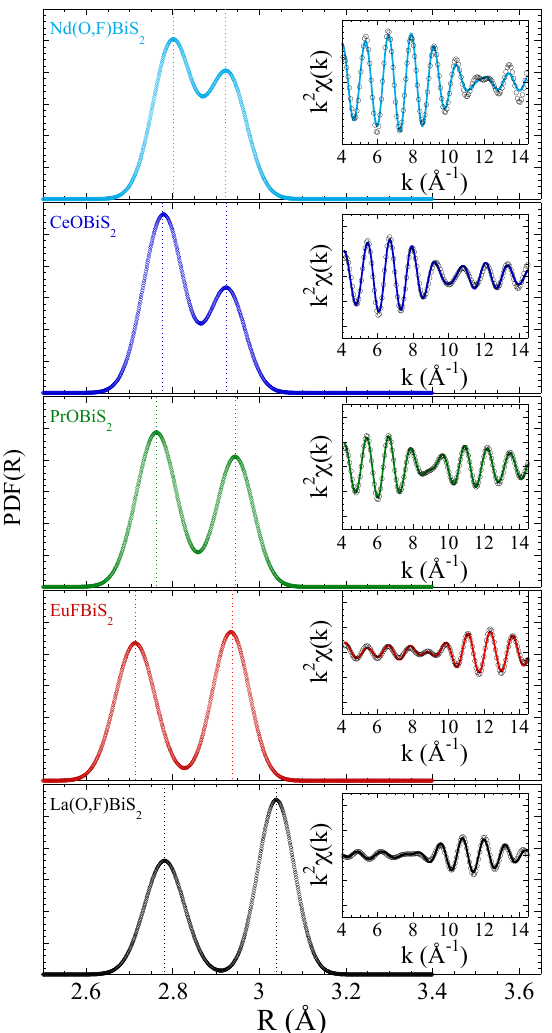
Figure 3. Bi-S1 bonds distribution functions obtained by in-plane polarized EXAFS measured on single crystal samples of RE(O/F)BiS 2 . The insets show the Fourier filtered EXAFS oscillations (symbols) compared with the theoretical EXAFS (solid line) corresponding to the plotted